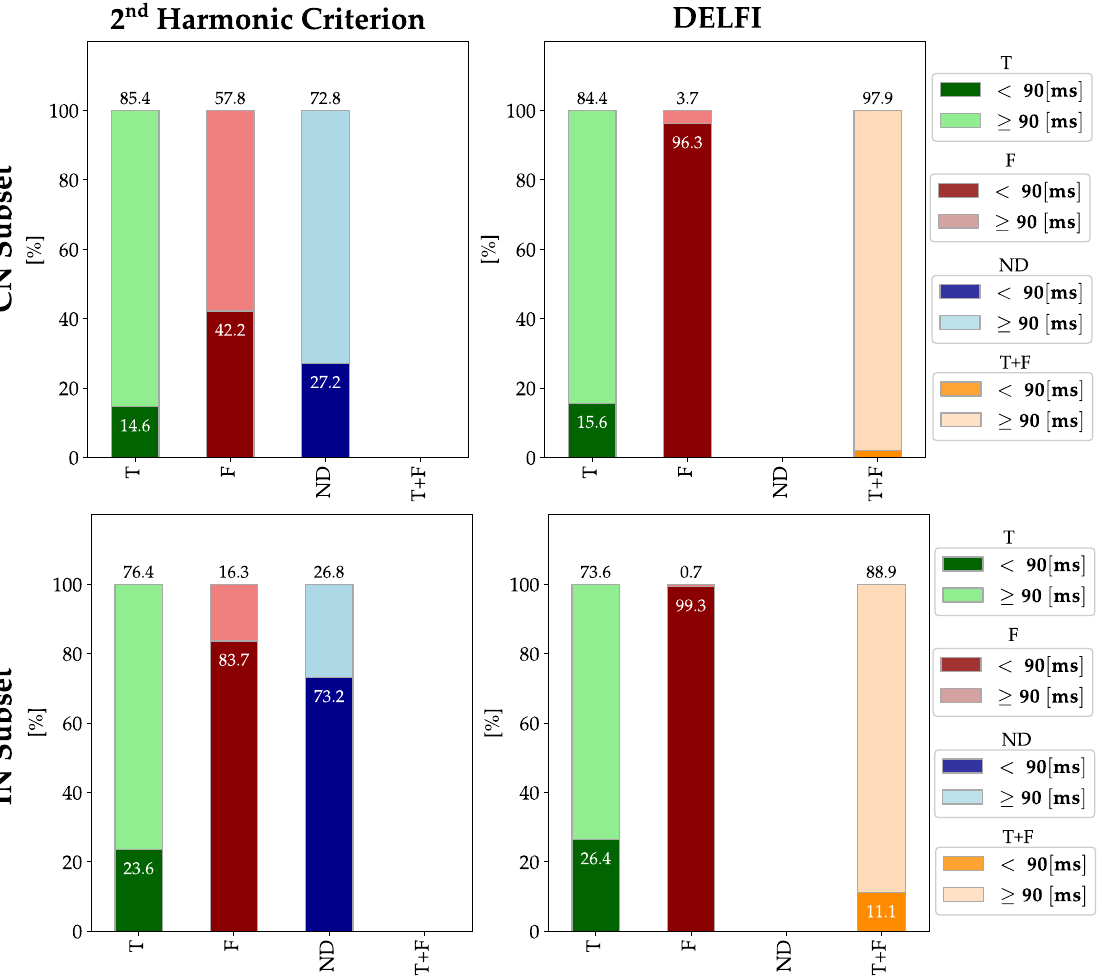
Figure 18. Duration subdivision for each class of the respective classifiers: CN Subset and IN Subset.